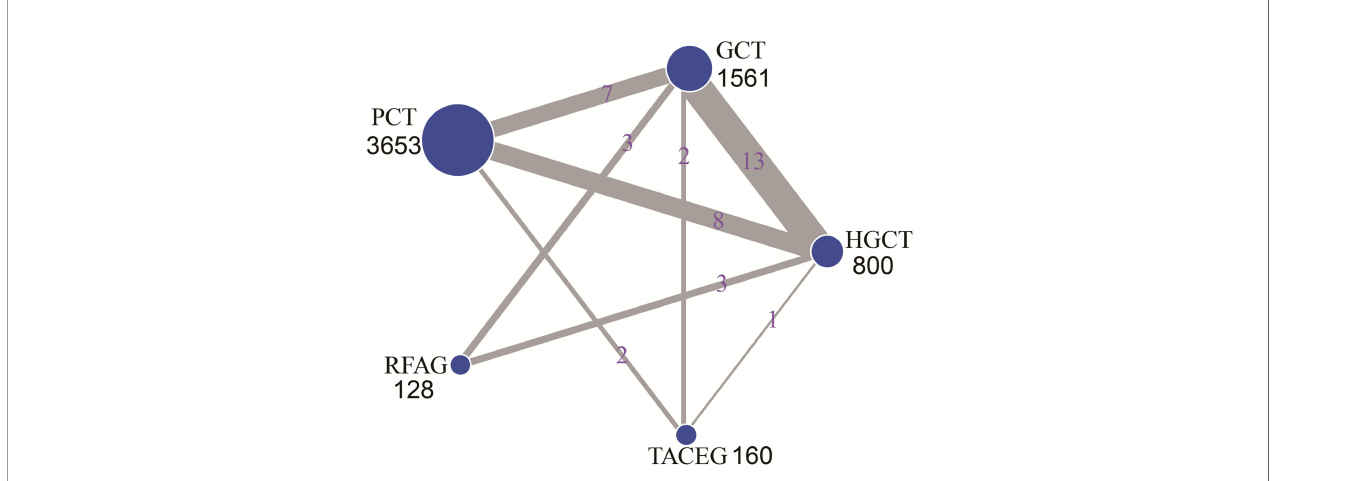
FIGURE 2 | Network of eligible comparisons for the multiple-treatment meta-analysis. The size of each node represents the total sample size of treatment. The thickness of each line represents the total number of studies that compare each other. HGCT, hepatectomy and gastrectomy plus chemotherapy; GCT, gastrectomy plus chemotherapy; PCT, palliative chemotherapy; RFAG, radiofrequency ablation and gastrectomy plus chemotherapy; TACEG, transarterial chemoembolization and gastrectomy plus